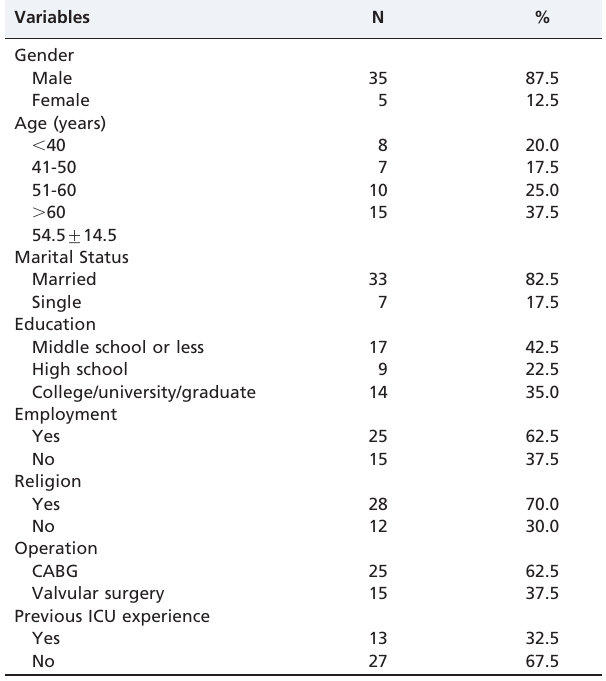
Table 1 - Characteristics of the study participants (n= 40).